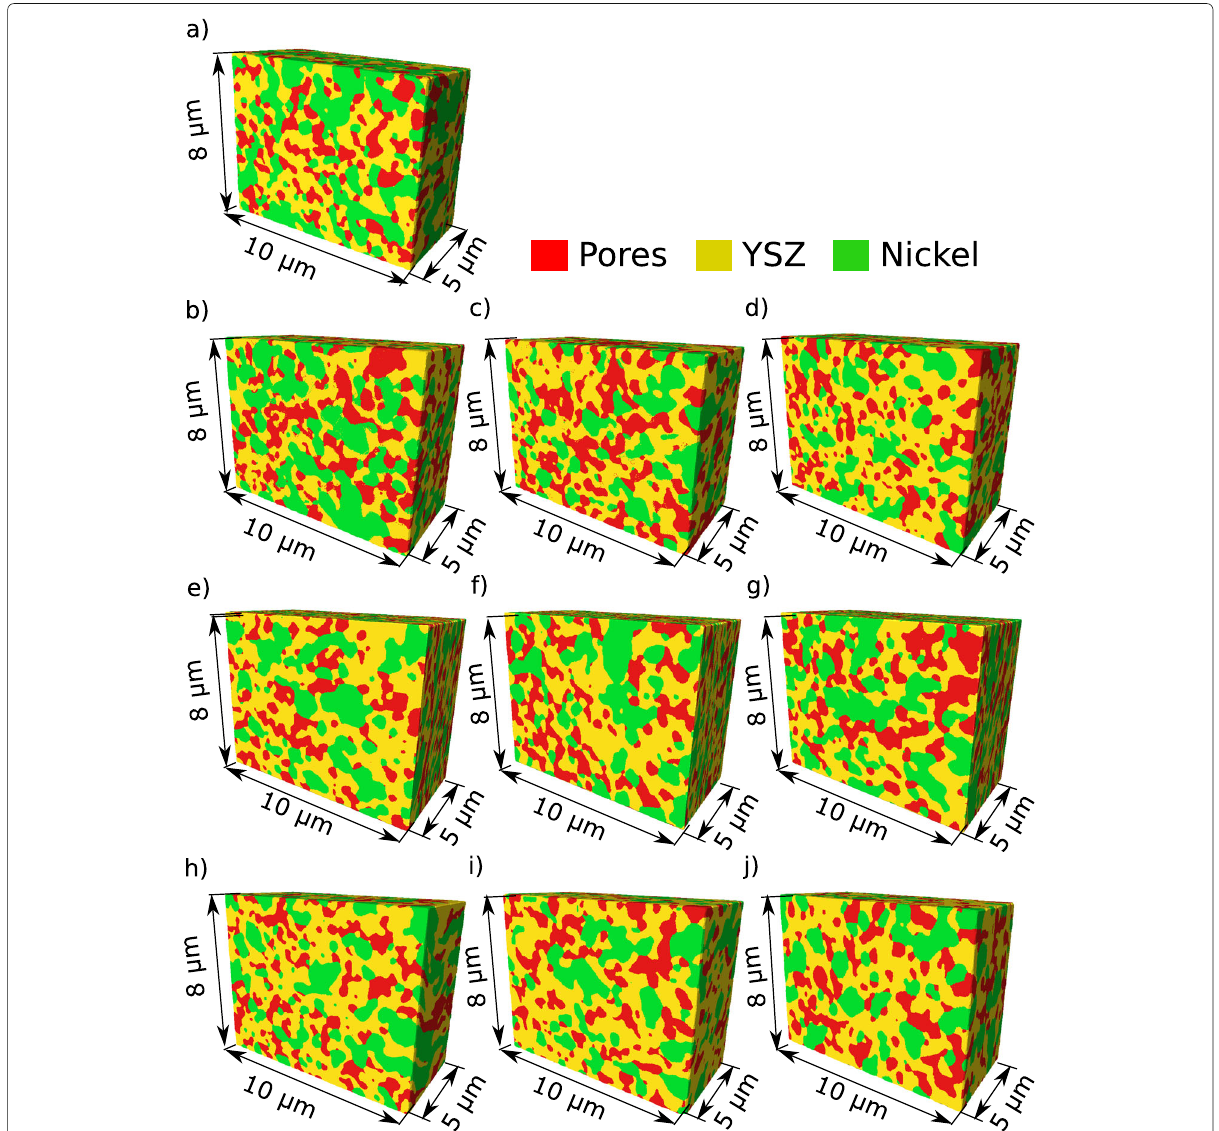
Fig. 6 Digital material representation of anode microstructure before and after the aging test. a Reference sample. b Cell 5 upstream. c Cell 5 center d . Cell 5 downstream e Cell 3 upstream. f Cell 3 center g . Cell 3 downstream. h Cell 1 upstream. i Cell 1 center. j Cell 1